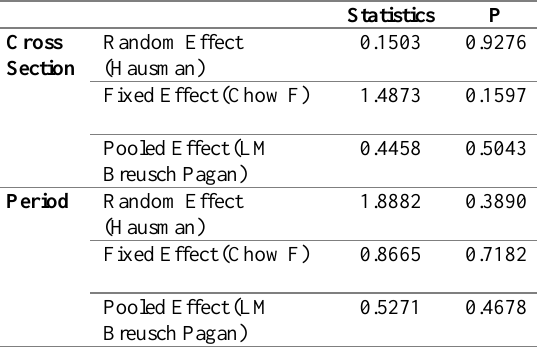
Table 5. Panel OLS effect test results